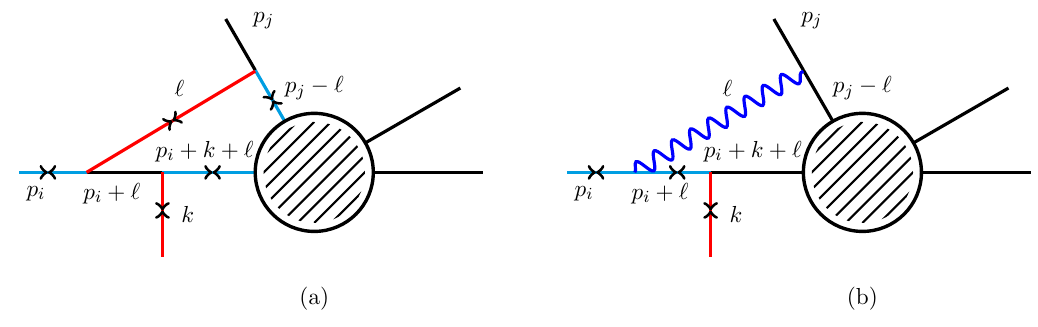
Figure 12 . Infrared divergence in supergravity